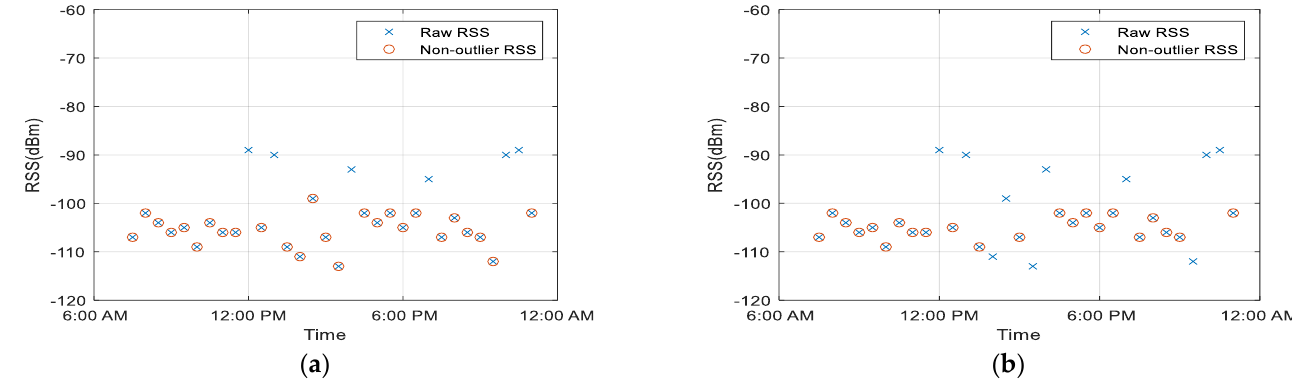
Figure 9. RSS outlier detection comparison for RSS Dataset 7. ( a ) 𝑆 𝑛 scale estimator, and ( b ) MAD scale estimator.